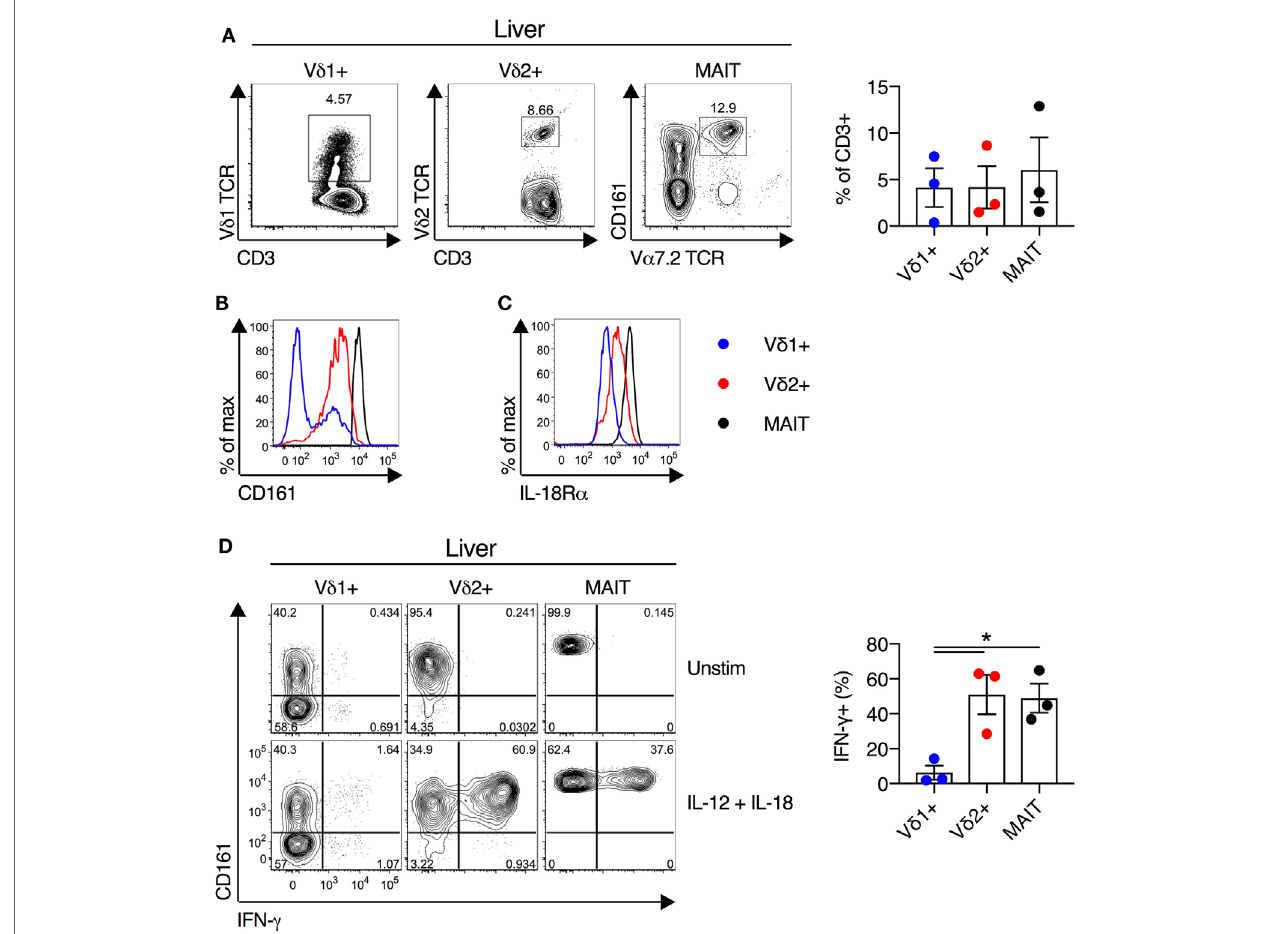
FigUre 5 | Human liver V δ 2 + γδ T cells maintain innate-like phenotype and function. Liver mononuclear cells were isolated from uninvolved tissue of colorectal cancer metastases or hepatocellular carcinoma patients. (a) Representative FACS plots and frequency of V δ 1 + γδ T cells, V δ 2 + γδ T cells, and mucosal-associated invariant T (MAIT) cells as a fraction of all liver CD3 + T cells. (B) Expression of CD161 on liver V δ 1 + γδ T cells, V δ 2 + γδ T cells, and MAIT cells. (c) Expression of IL-18R α on liver V δ 1 + γδ T cells, V δ 2 + γδ T cells, and MAIT cells. (D) Liver mononuclear cells were stimulated for 20 h with IL-12 and IL-18 (50 ng/ml). Brefeldin A and Monensin were added for the final 4 h. Representative FACS plots and group summary of IFN- γ production by each cell subset in response to cytokine stimulation. Mean ± SEM. Symbols represent individual donors ( N = 3), pooled from three independent experiments. * P < 0.05. Paired T